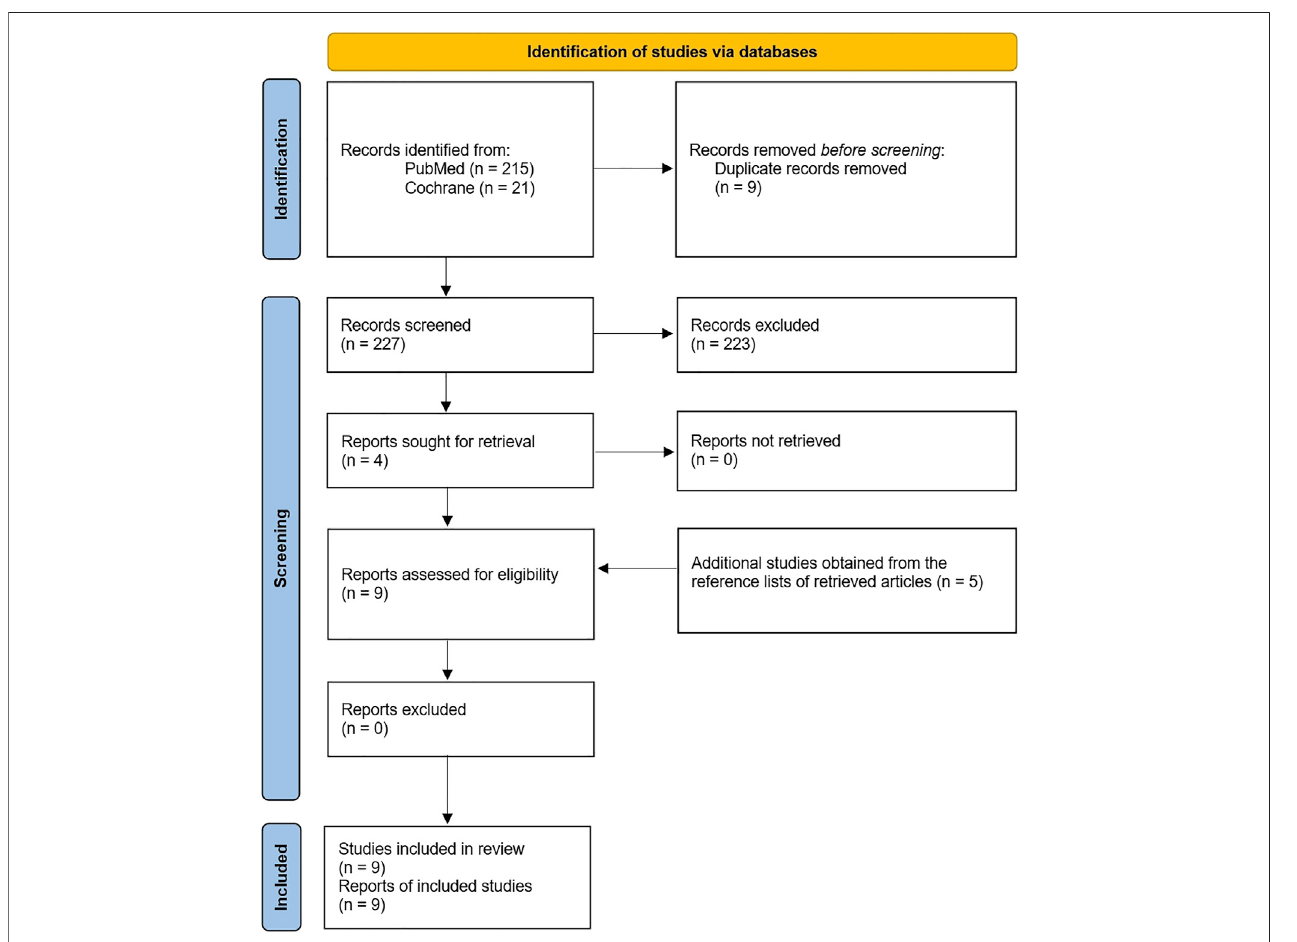
FIGURE 2 | Flow diagram of study selection.